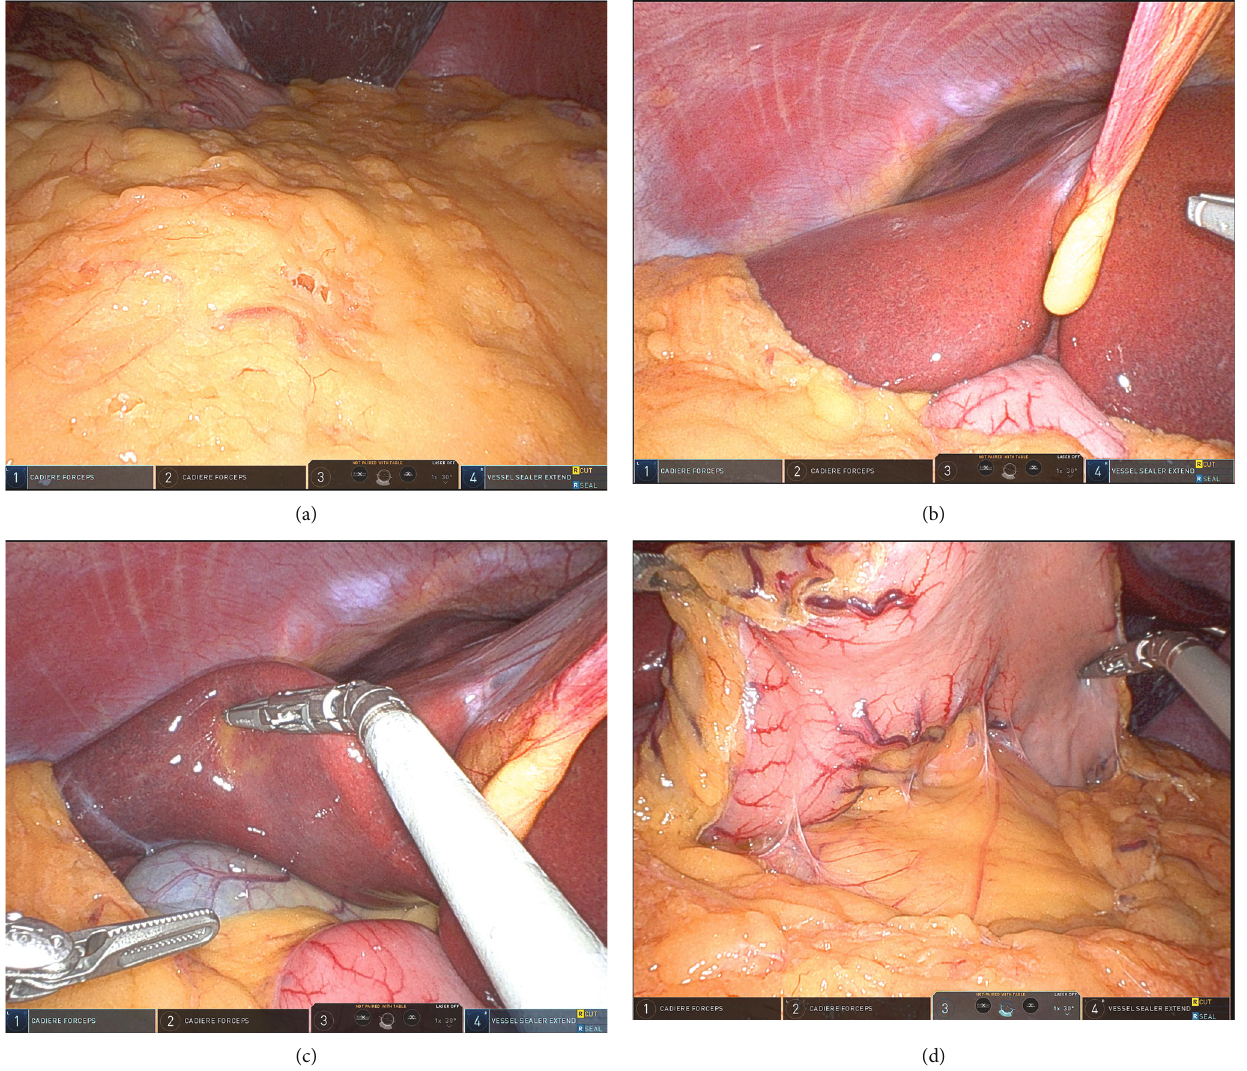
Figure 3: (a) Intraoperative images showing no bile, succus, or free fl uid on abdominal entry. (b – d) Examination of all four quadrants as well as opening lesser sac were